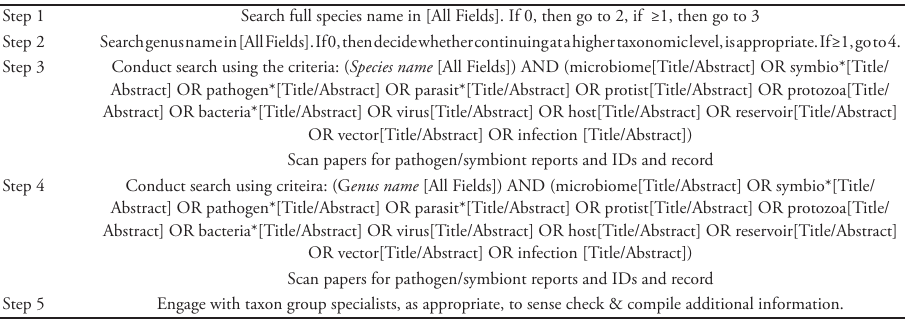
Table 1. The process undertaken to find information on pathogens, parasites and symbionts associated with each species, with a suitability score of ≥0.15, on PubMed. Only steps one to three were carried out in the present study (adapted from Foster et al.